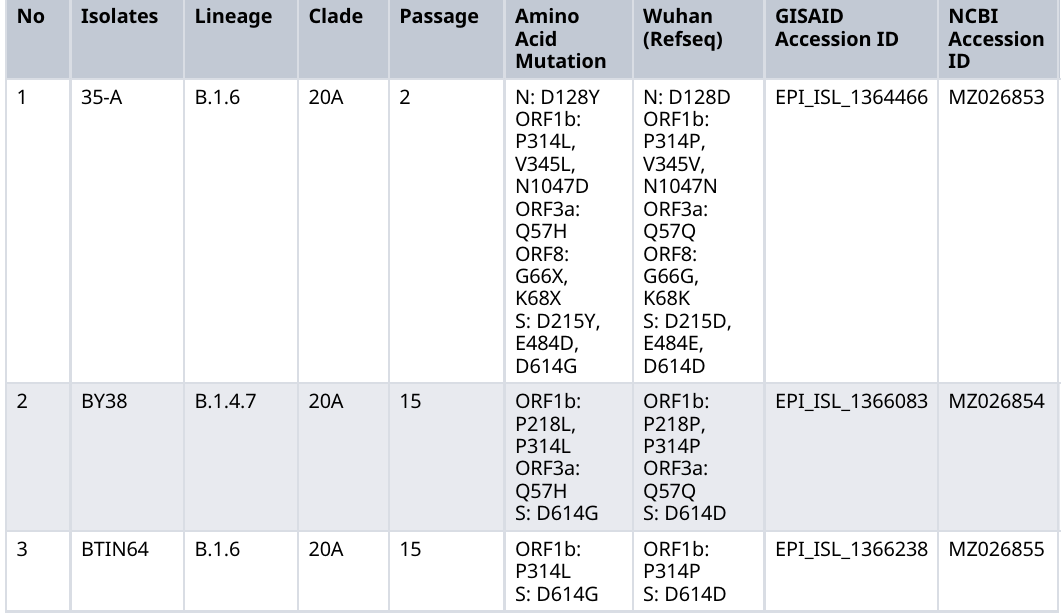
with plaque formation. 26 Evaluation during virus passage exhibited a shorter time for developing CPE in line with increasing passage numbers that indicated a more adapted virus culture. The serial passage of virus in the culture exhibit with shorter CPE formation indicated increases in virus titers, adaptation, and more virus replication efficiency. 41 SARS-CoV-2 infection was confirmed by SEM, STEM, and RT-PCR examination. SEM observation showed a three- dimensional structure of viral particles without spike protein visualization with a viral particle diameter that was in line with previously reported cases. STEM observation showed cross-sectional images of viral particle structure, with spike